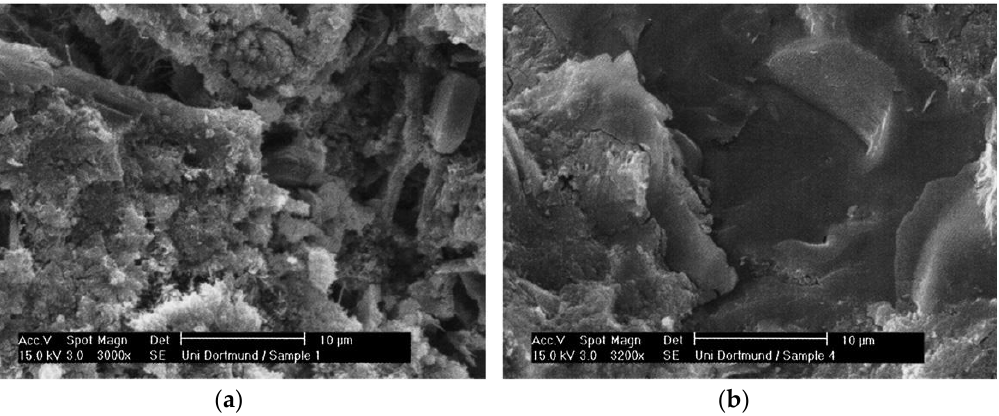
Figure 3 . Microstructure of two foam concrete; ( a ) w/c = 0.60, containing no microsilica content; ( b ): w/c ratio = 0.35, with 10% microsilica content. Reprinted/adapted with permission from Ref. [116]. 2009, Elsevier Science &Technology Journals.